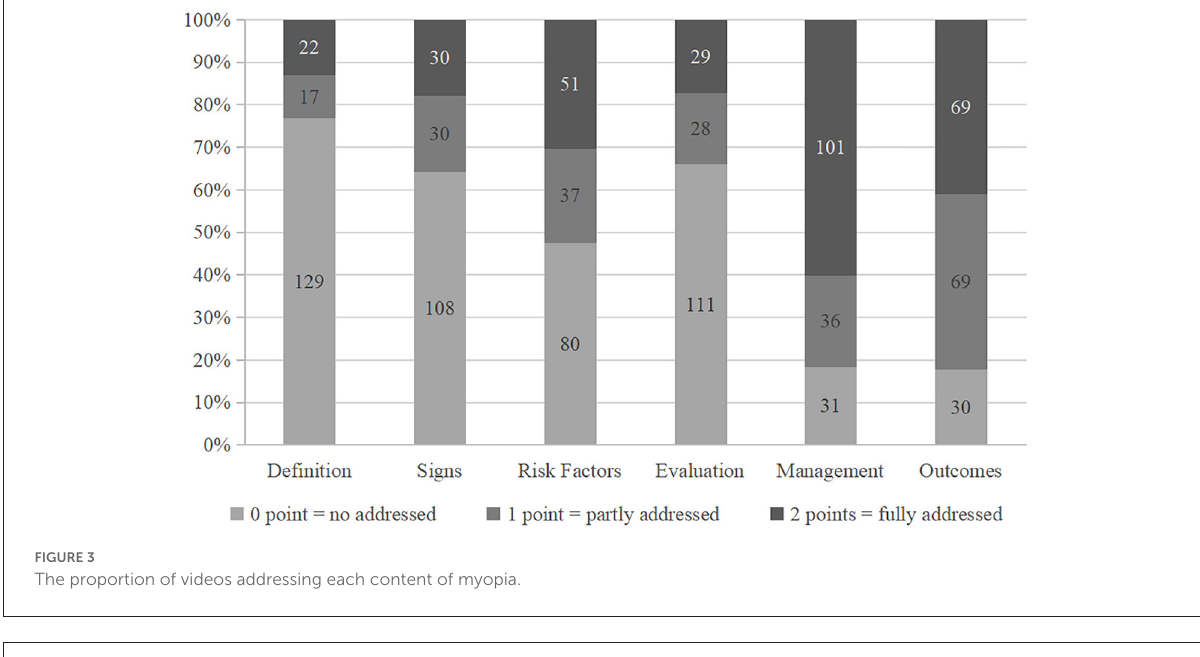
FIGURE3 The proportion of videos addressing each content of myopia.